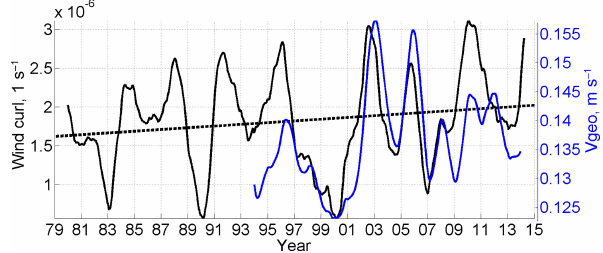
Figure 4. The interannual variability of the basin-averaged wind curl (black curve) in 1980–2014 and the basin-averaged speed of surface geostrophic currents (blue curve) smoothed with a 1-year moving